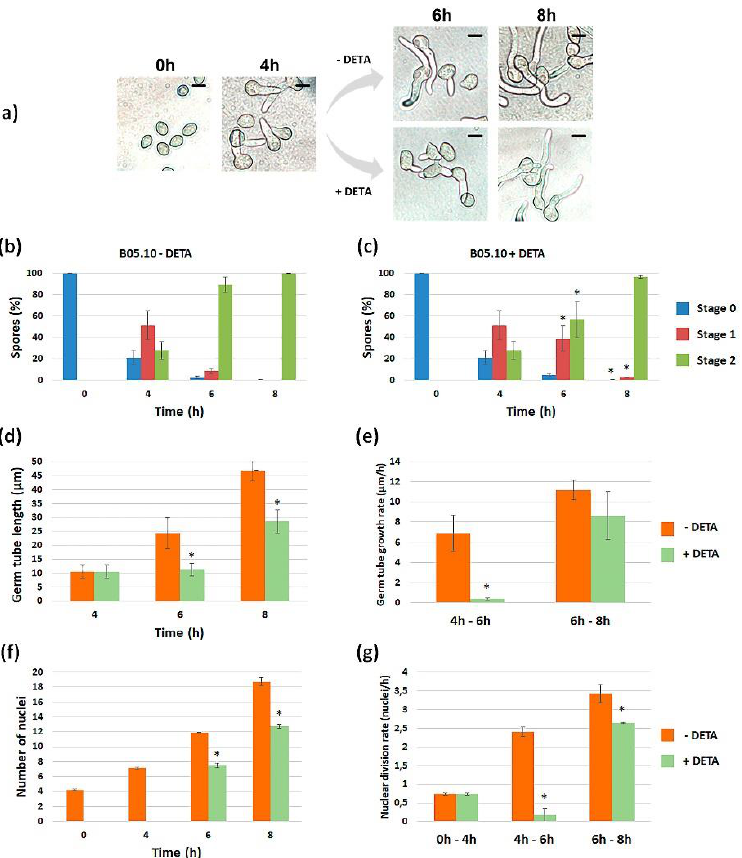
Figure 5. Effect of the addition of 250 µ M DETA to B05.10 spores once the germination program had been launched. ( a ) Experimental set-up and representative images taken at the indicated time points and conditions. ( b , c ) Percentages of spores in the different stages of development (0, 1 and 2) at the indicated time points in the absence ( b ) and presence ( c ) of 250 μM DETA. ( d ) Average germ tube length at the indicated time points. ( e ) Germ tube growth rate at 4–6 and 6–8 h. ( f ) Average number of nuclei in spores and germ tubes at the indicated time points. ( g ) Average nuclear division rate at 4–6 and 6–8 h. The data present the means of three replicates ± SD ( n ≥ 100 each). (* indicates significant differences at p < 0.05—Student’s t -test—in the presence of 250 μM DETA and its reference situation in the absence of DETA.) Scale bars, 10 µm.